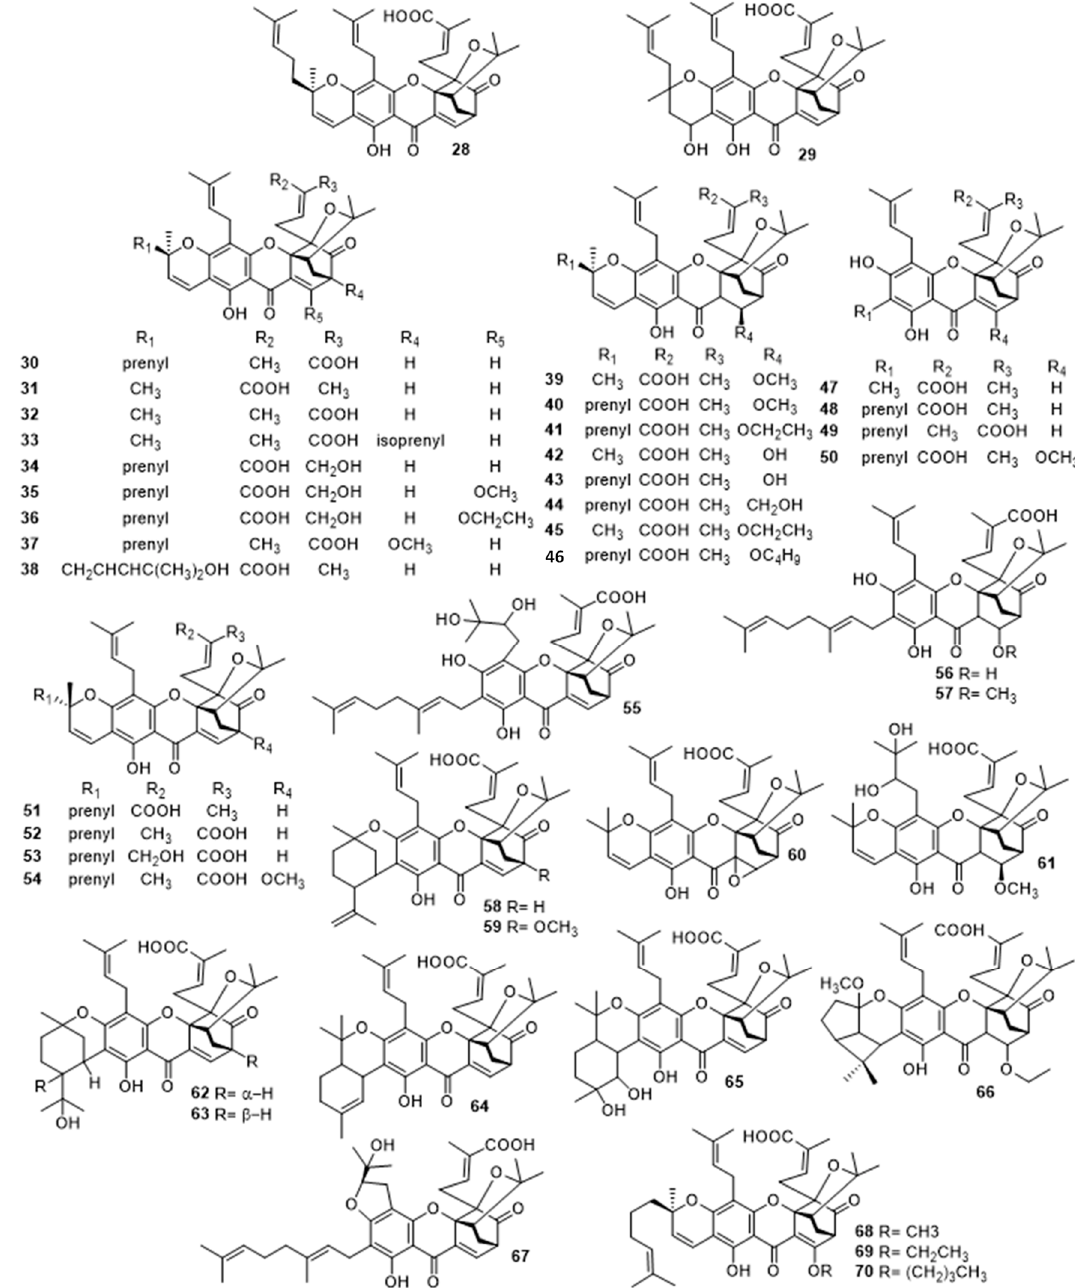
Figure 4. Structures of gambogic acid ( 28 ) and analogues ( 29 – 70 ).